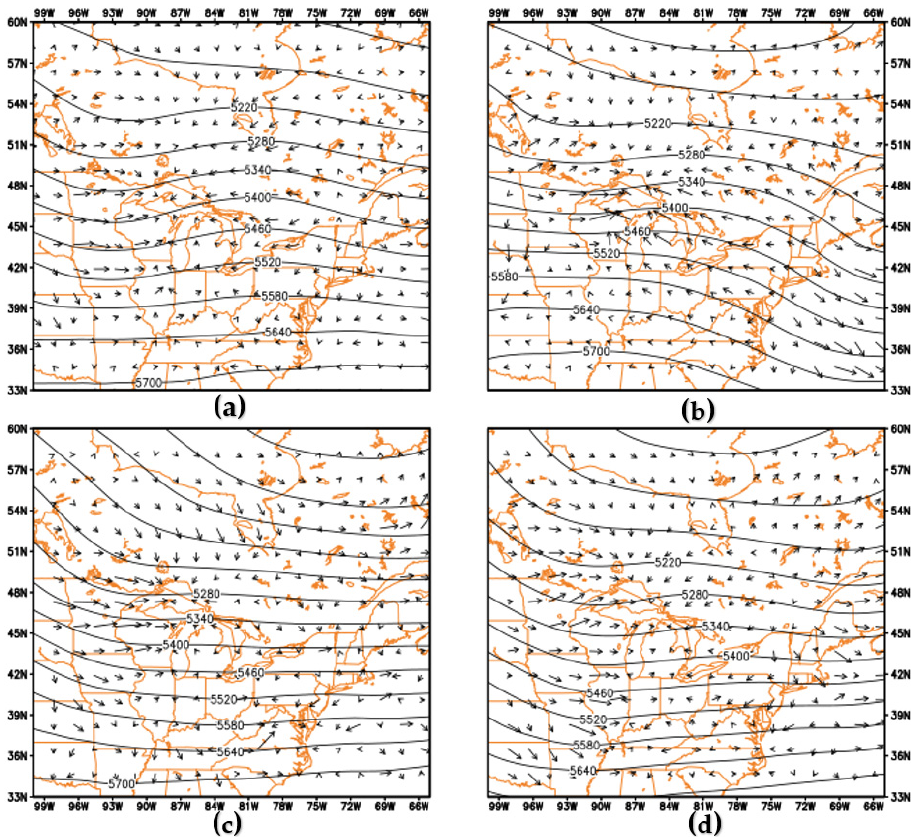
Figure 6. 500 mb geopotential heights (m; contours) and Q-vectors for Cluster 1 ( a ), Cluster 2 ( b ), Cluster 3 ( c ), and the LES composite ( d ) while the clipper was located at 90° W.